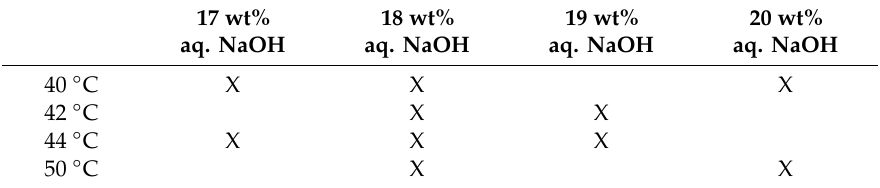
Table 2. Trial scheme for preparation of residues for further